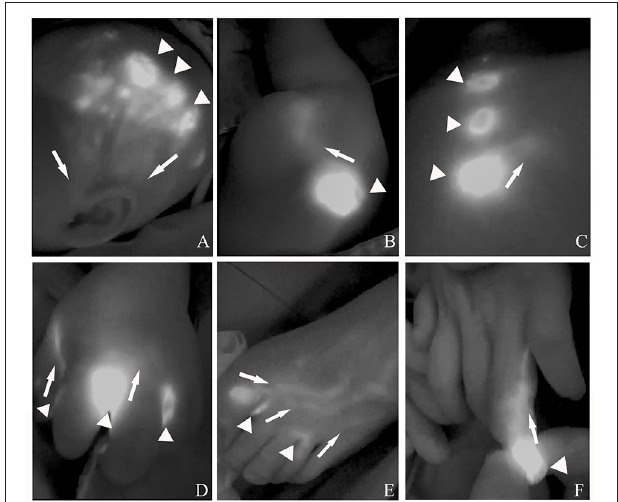
FIGURE 1 | The selection of indocyanine green (ICG) injection points for detecting inflows of cystic lymphatic malformations (cLM) at the (A) cervicofacial region, (B) chest, (C) abdomen or back, (D) upper extremities, (E) lower extremities, and (F) digits. Arrow head , lymph vessel; triangle , ICG injection